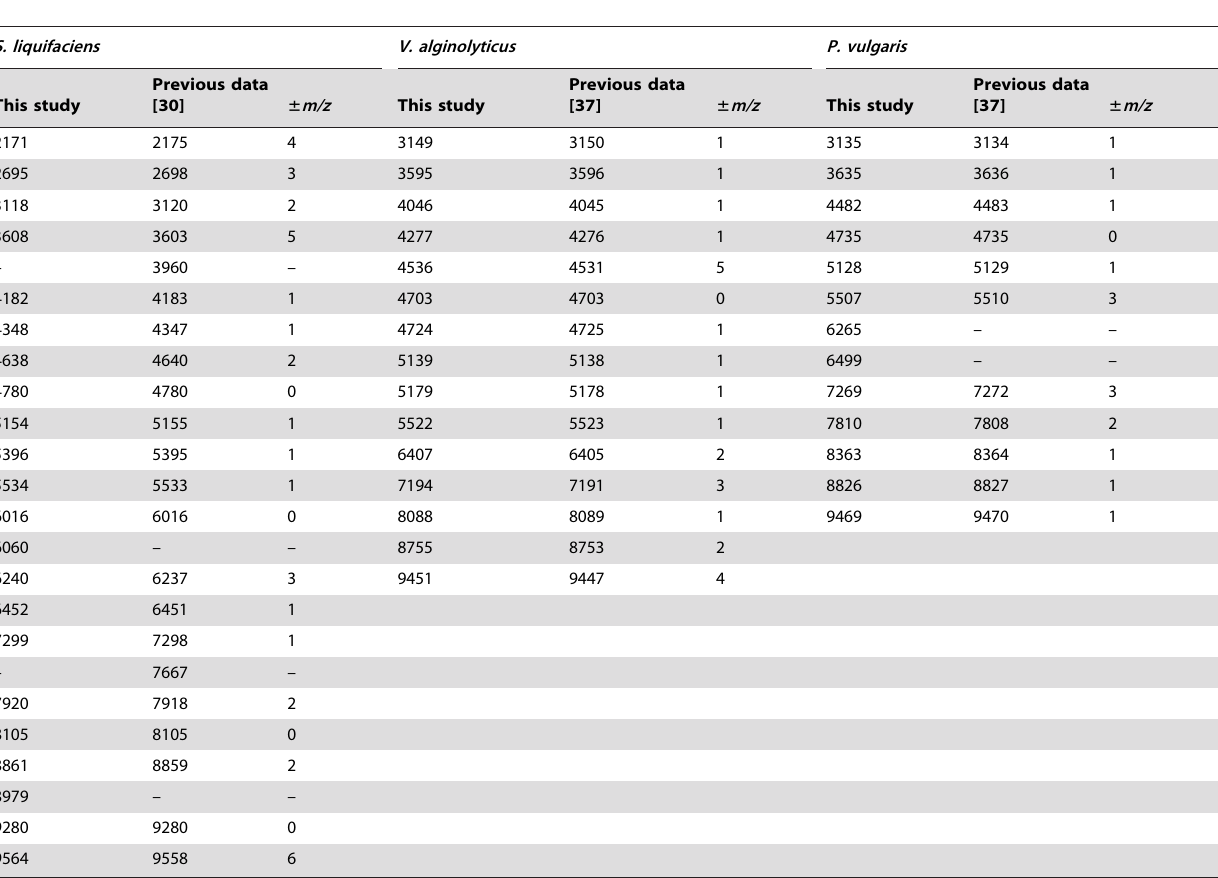
Table 2. Mass spectral peak list comparing three marine bacterial species isolated in this study with previously published